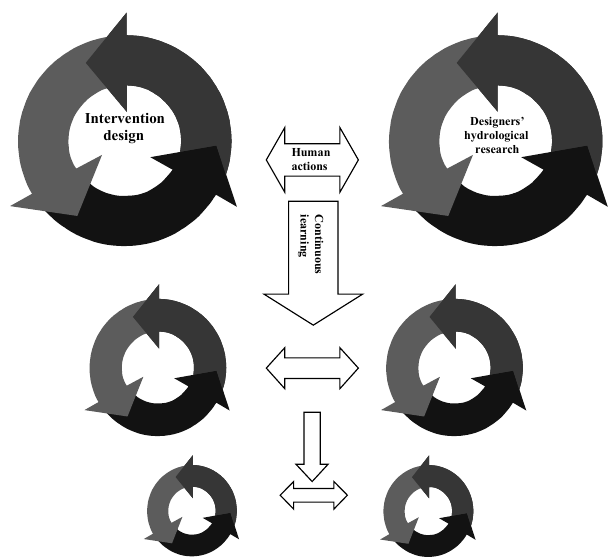
Figure 6. Designing hydrological field research in small-scale in- tervention (modified from Ertsen, 2002, and Scheer,